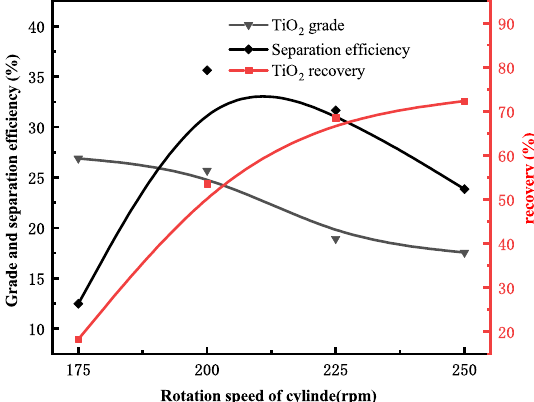
Figure 5. Effect of rotation speed of cylinder on performance.